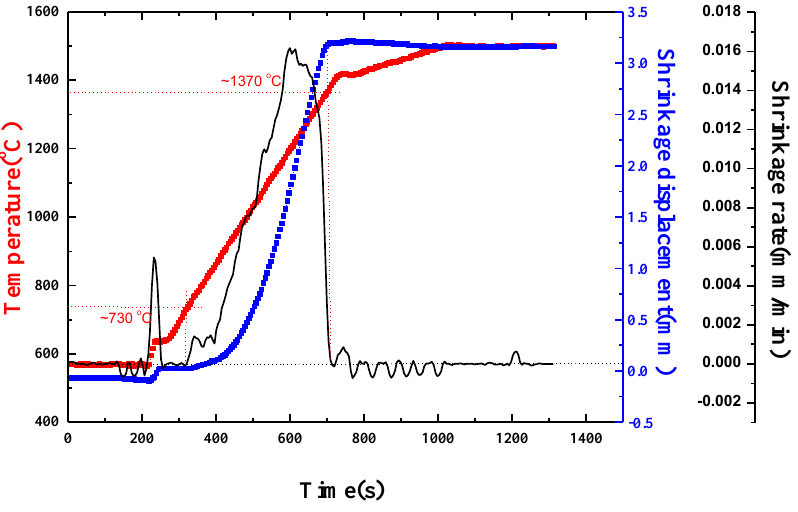
Figure 2. Densification curves for TiB 2 –5 wt% (Fe–Ni–Ti–Al) blended powders sintered at 1500 °C and held for 5 min under 50